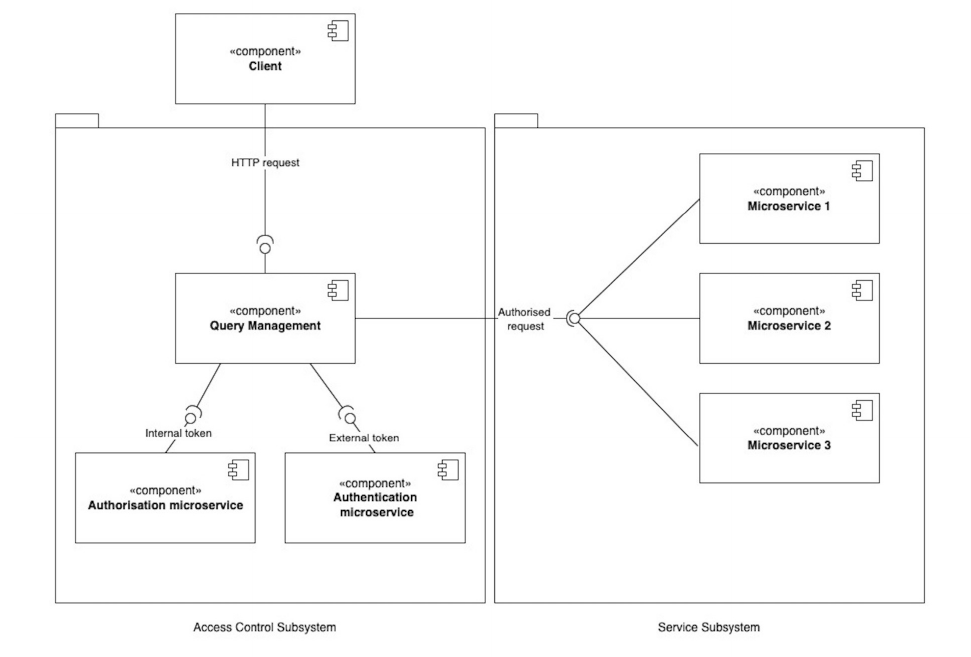
Figure 3. Diagram of the components for centralized access control in